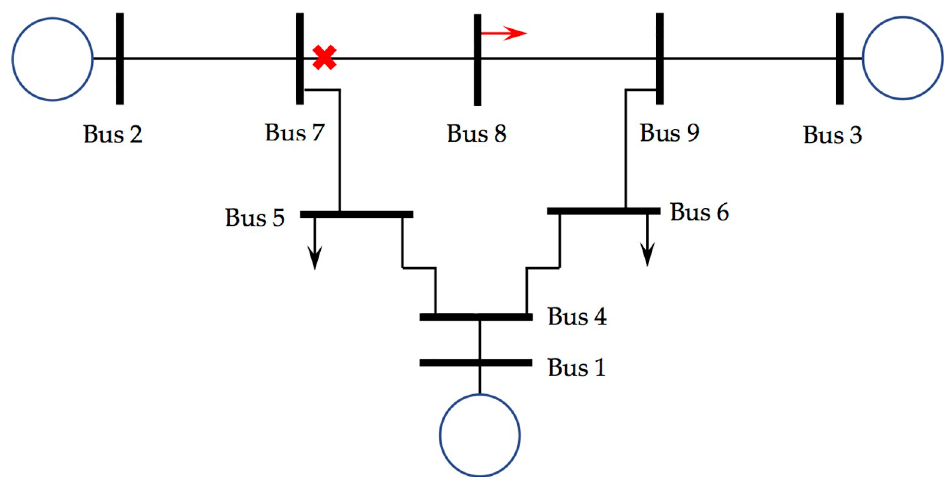
Fig 5. IEEE 9-bus system. The red arrow and red cross represent the loss of load and the line fault, respectively.